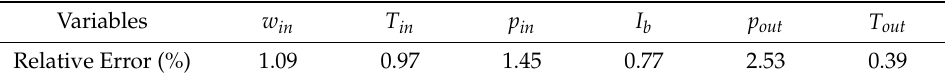
Table 2. The relative error between actual output and model